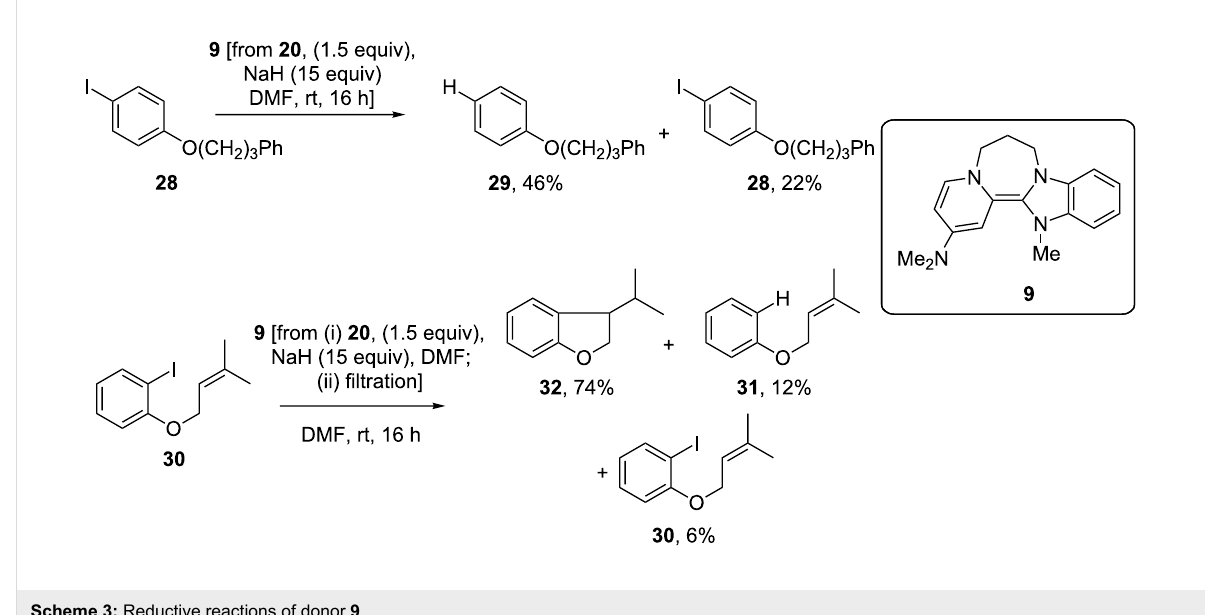
Scheme 3: Reductive reactions of donor 9 .